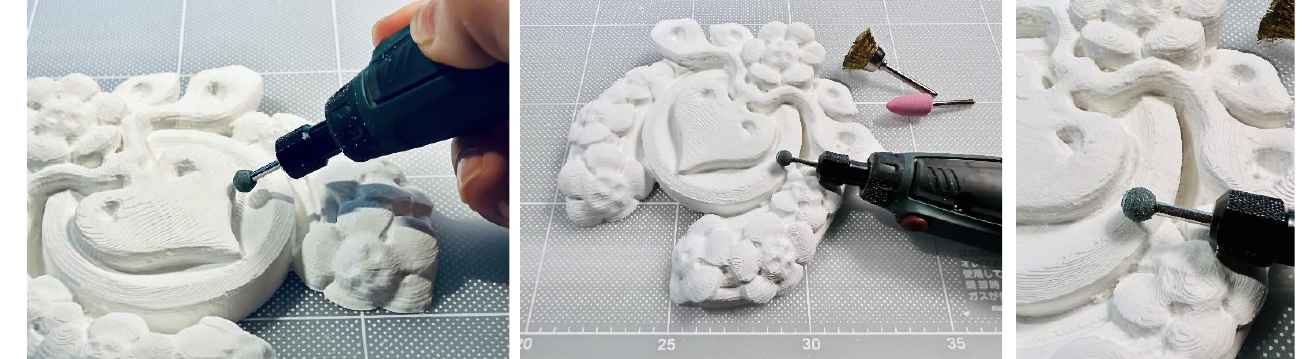
Figure 18. Post-processing by cleaning and polishing the 3D printed ornaments from the Lajos (Ludwig) Besch and Karoly (Karl) Piffl Palace.